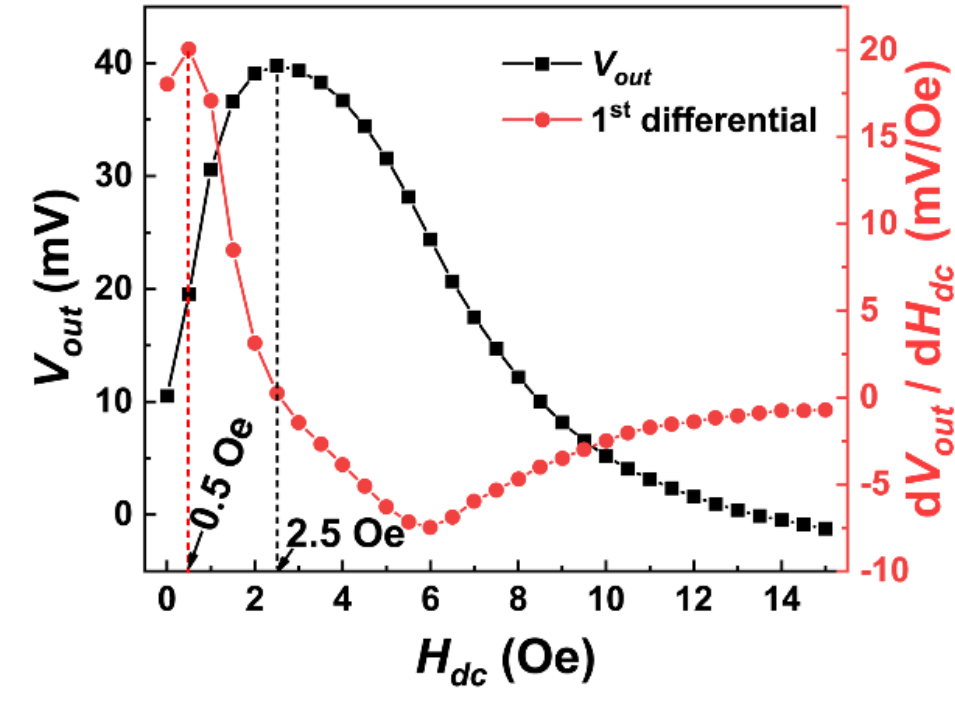
(𝐻 ) curve and its differential curve at 𝑓 𝑜𝑢𝑡 𝑑𝑐